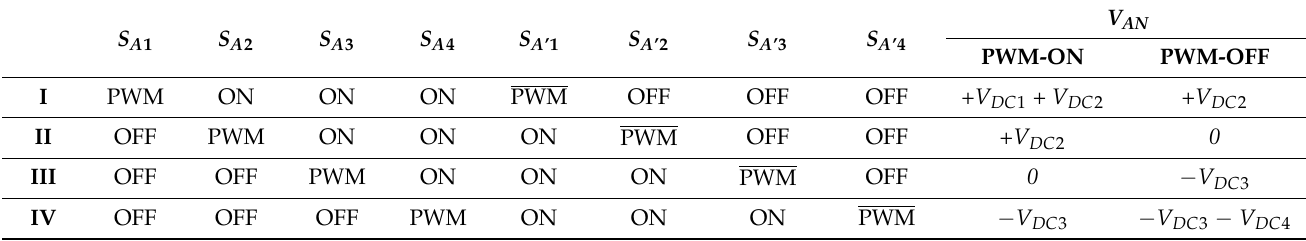
Table 1. Switching states and STATCOM output voltages of phase A.